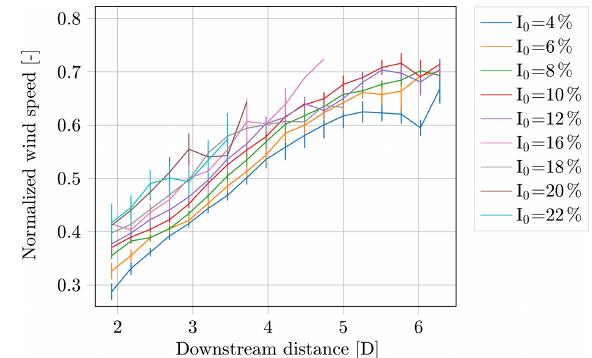
Figure 12. Measured mean value (line) and standard deviation (bar) of the mean value of the minimal wind speed in the HMFR for dif- ferent turbulence intensity bins with a bin width of